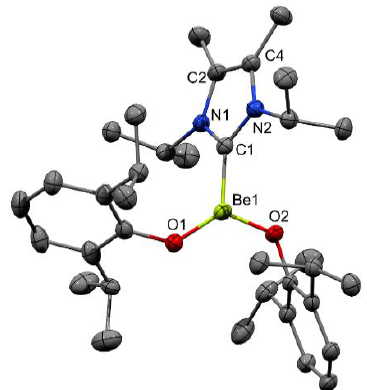
Figure 2. Molecular structure of 2 (thermal ellipsoids at 50% probability; H atoms omitted for clarity). Selected bond distances (Å) and angles (deg): Be1 − O2: 1.497(3); Be1 − O1: 1.507(3); Be1 − C1: 1.797(3); N1 − C2: 1.393(2); N1 − C1: 1.353(2): N1 − C2: 1.359(2); N2 − C4: 1.391(2); C2 − C4: 1.362(3). O2 − Be1 − O1: 122.34(17); O2 − Be1 − C1: 112.66(15); O1 − Be1 − C1: 124.99(17).